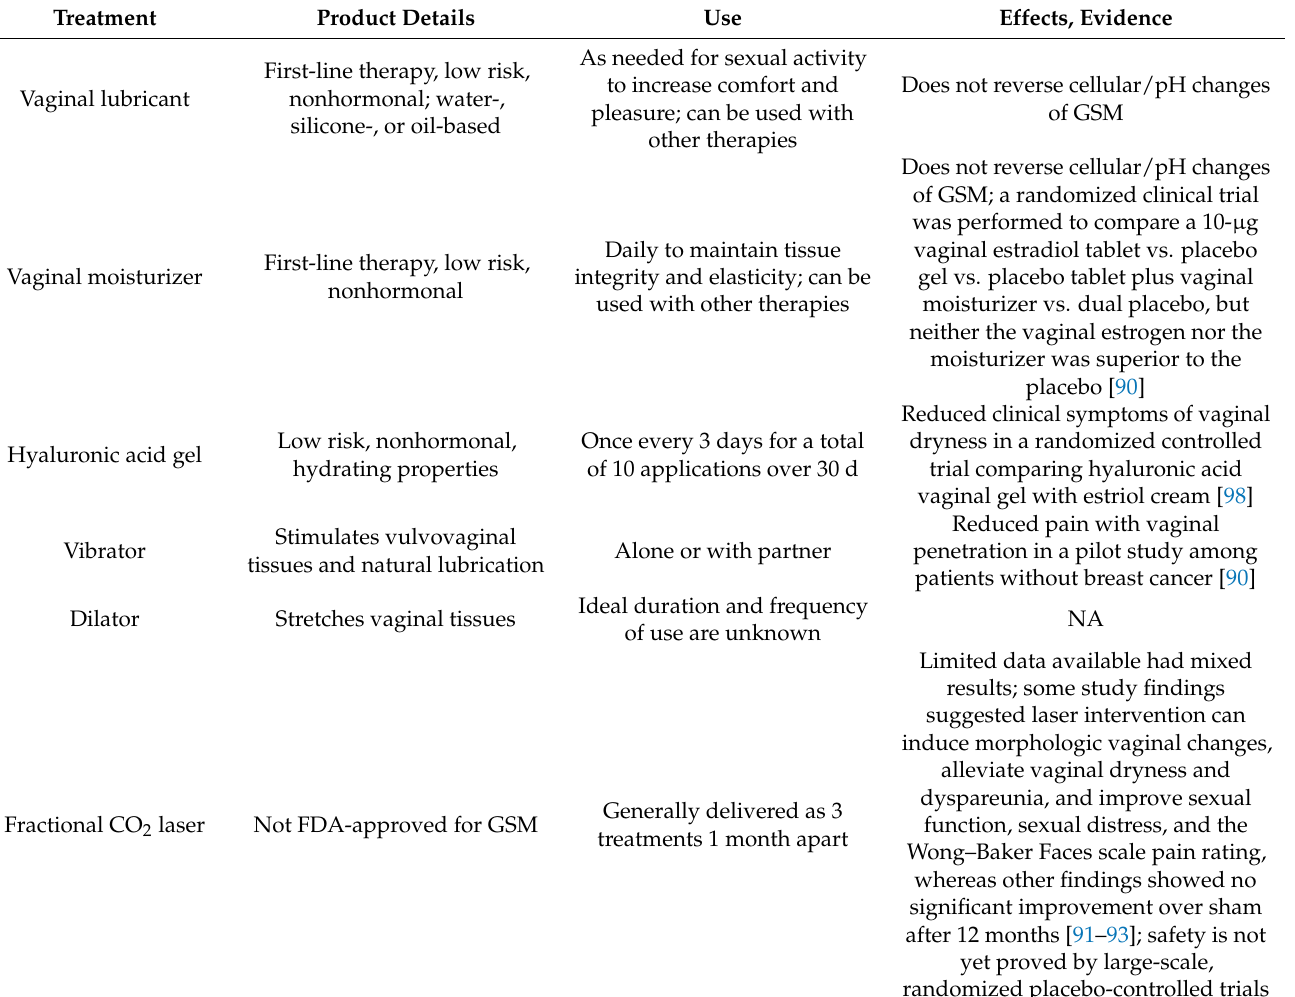
Table 3. Nonpharmacologic and Nonhormonal Treatment Strategies for GSM Not Contraindicated for Use by BC